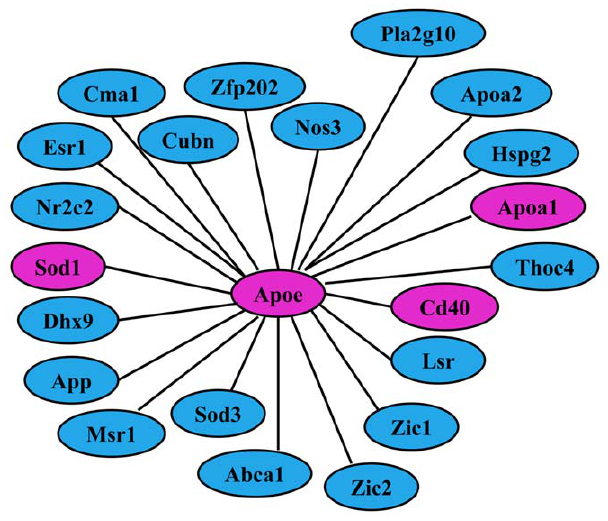
Figure 5. Known protein-protein and protein-DNA interactions around ApoE curated from interaction databases and the literature. Nodes colored in pink are those identified by our method as differentially connected between BxH/wt vs. BxH/apoe 2 / 2 .